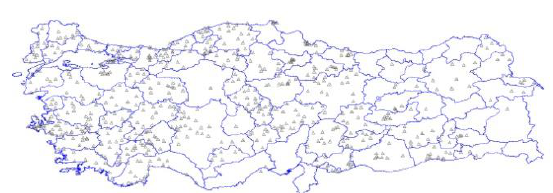
Figure 6. Distribution of 700 Ground Control Points measured by CORS-TR System